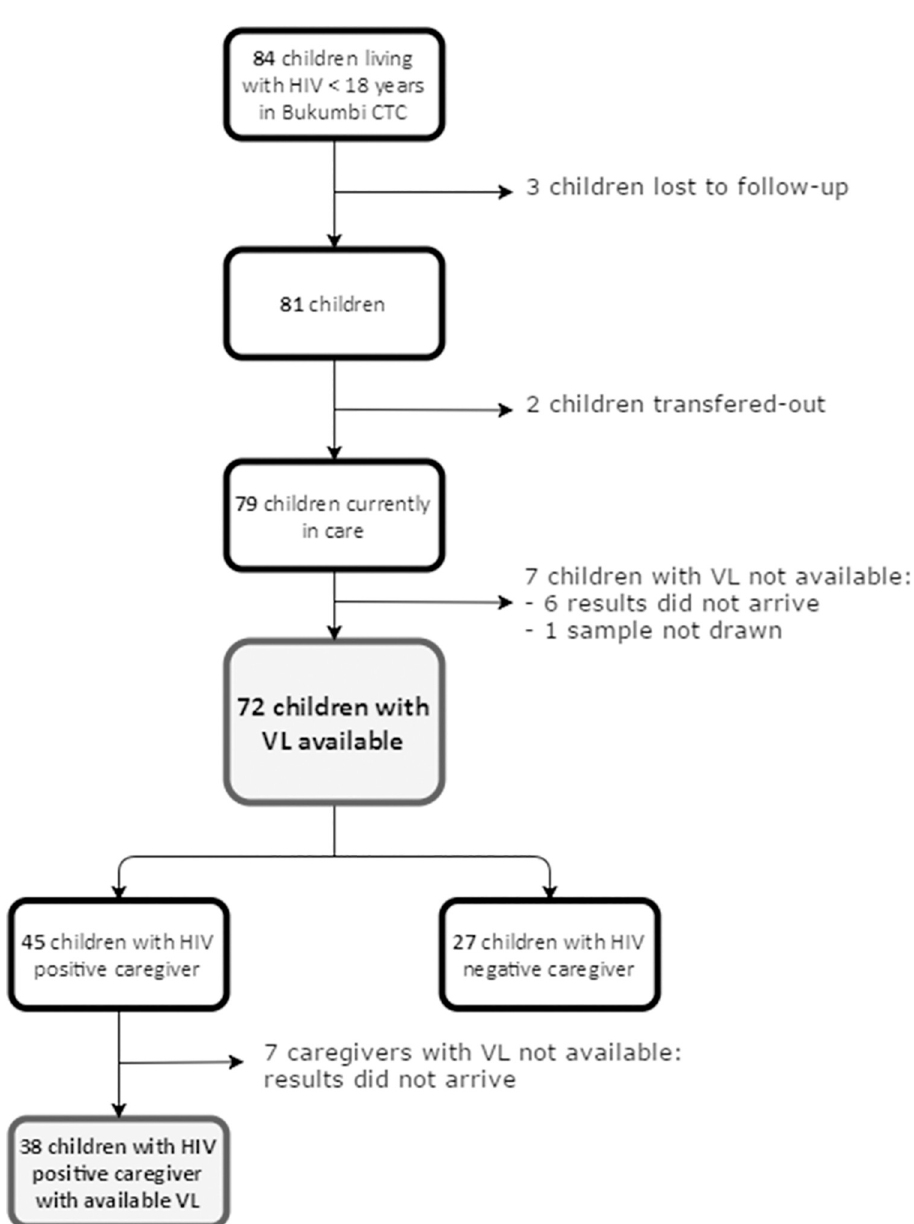
Fig 1. Flow diagram of enrolled population. CTC = Care and Treatment Clinic, VL = HIV viral load.